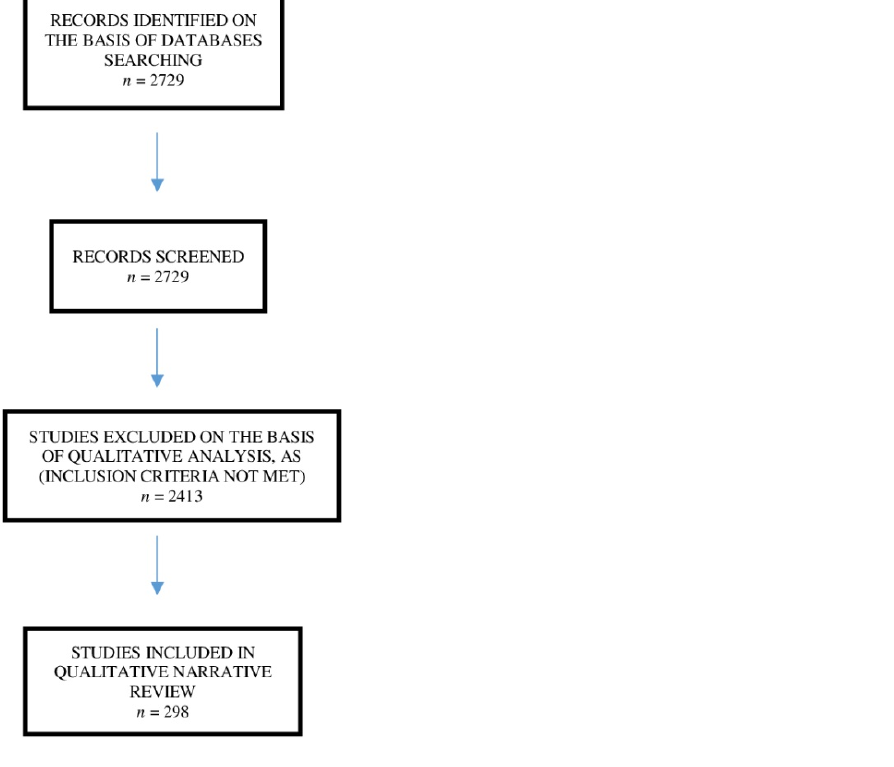
Figure 1. Flowchart diagram of studies selection process according to the inclusion